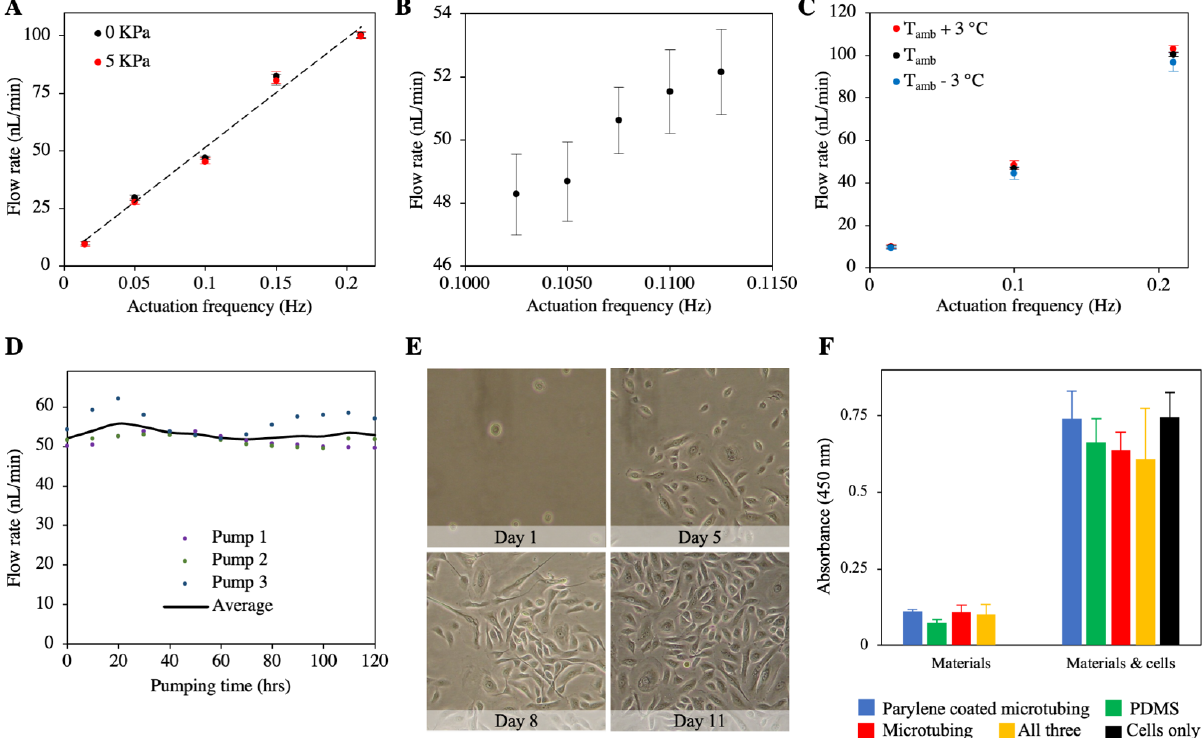
Figure 2. ( A ) Benchtop characterization of the micropump showed a linear (R 2 = 0.98) relation between the actuation frequency and the flow rate, indicating effective control over the flow rate. The application of 5 kPa backpressure did not significantly change the flow rate. Error bars: standard deviation. ( B ) The micropump had a 2.35 nL/min resolution in delivering at the target flow rate of 50 nL/min. Error bars: standard deviation. ( C ) A ±3°C fluctuation in the ambient temperature had an insignificant impact on the flow rate. Error bars: standard deviation ( D ) The micropump could provide a consistent flow rate for 120 h after stabilization, with an average of 53.1 ± 1.8 nL/min (mean ± standard deviation), with fluctuations smaller than 5%. ( E ) In vivo biocompatibility experiments of the micropump components showed an increase in the numbers of proliferating cells and normal development of cell morphology over time. ( F ) Results of XTT assays with 120 min incubation time at Day 7 showed insignificant between-group differences for cell health, biocompatibility, and viability for any of the micropump component conditions, confirming biocompatibility of the micropump components. Error bars: standard error of the mean. ( A – C , E , F ) adapted from [36].